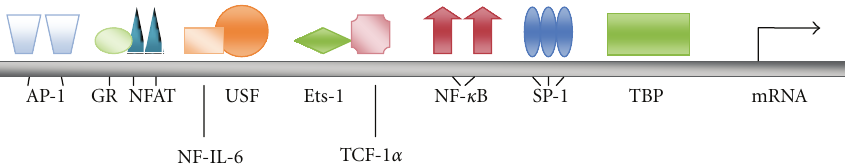
Figure 2: Critical transcription factor binding sites within the HIV-1 long terminal repeat (LTR) that facilitate upregulation of latent HIV-1.